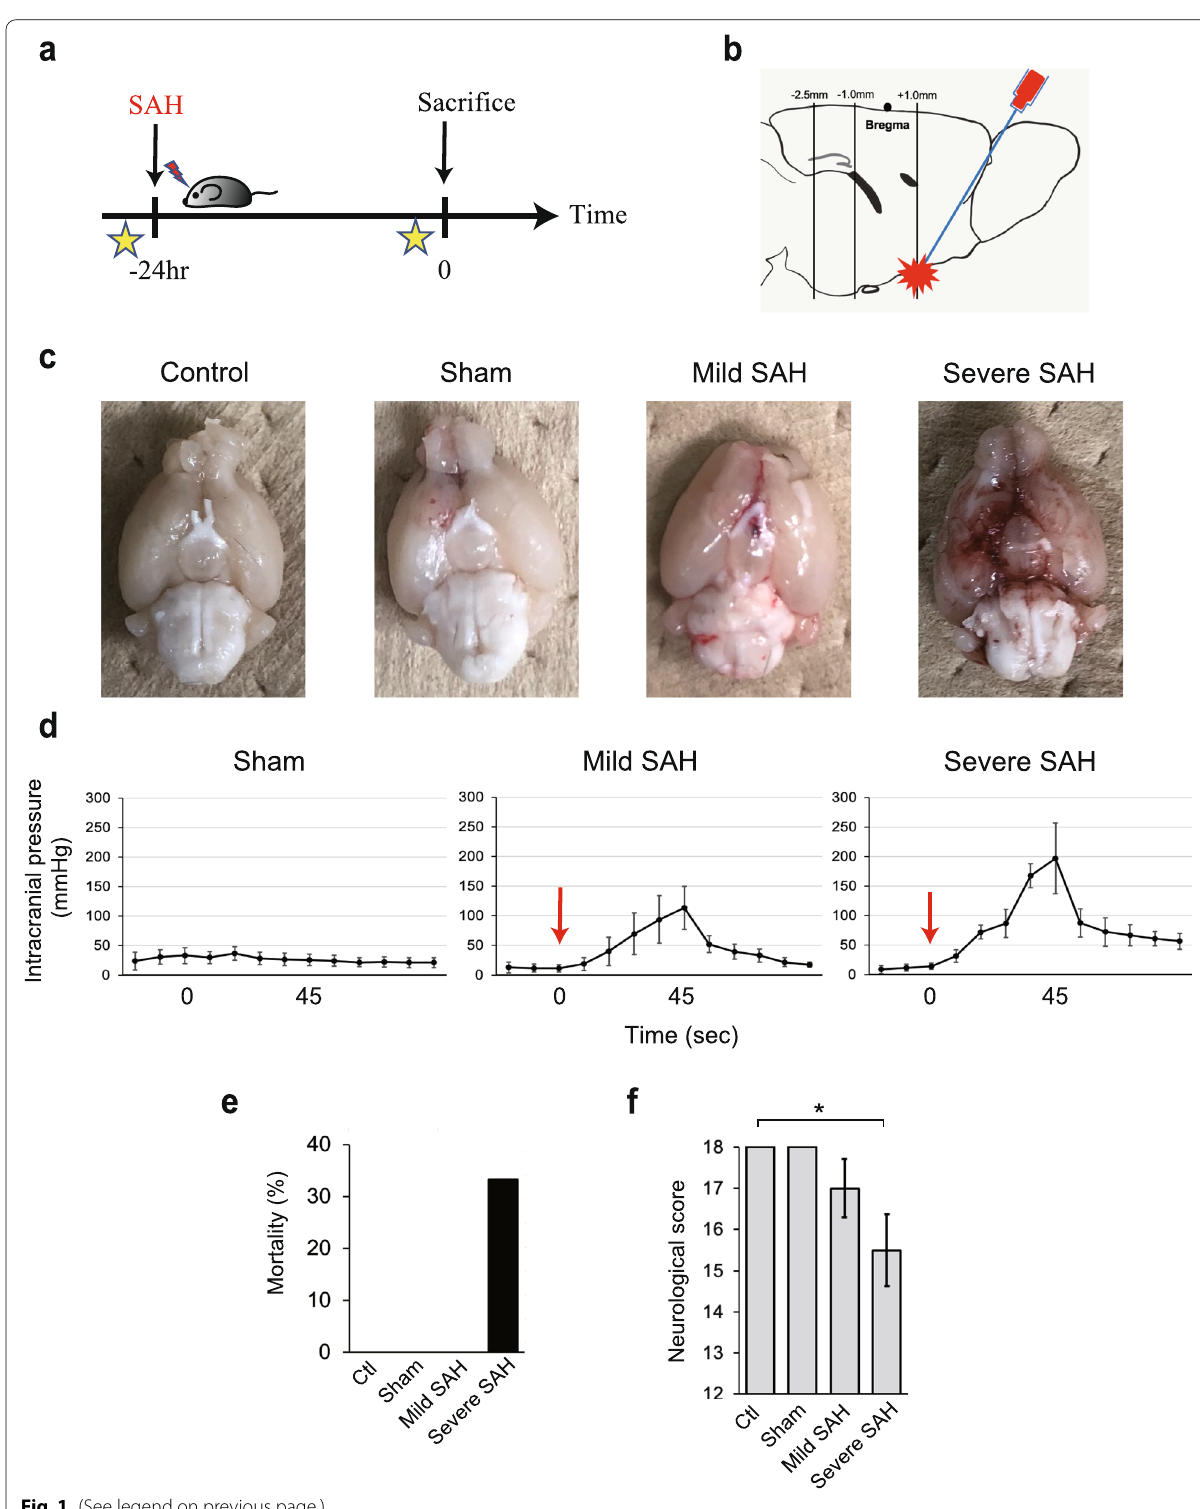
Fig. 1 (See legend on previous